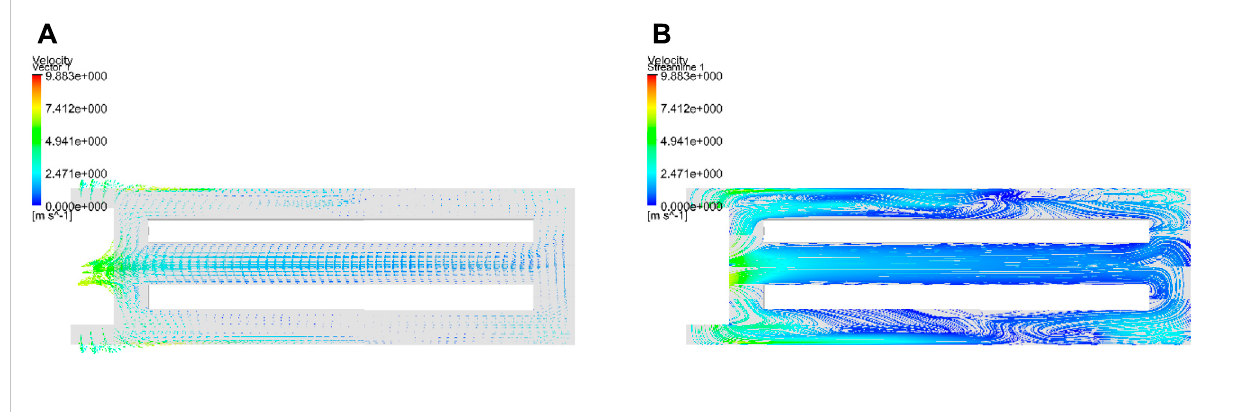
FIGURE 17 Instantaneous velocity vector fi eld (A) and velocity streamline plot (B) obtained at 2,400 s for the optimized con fi